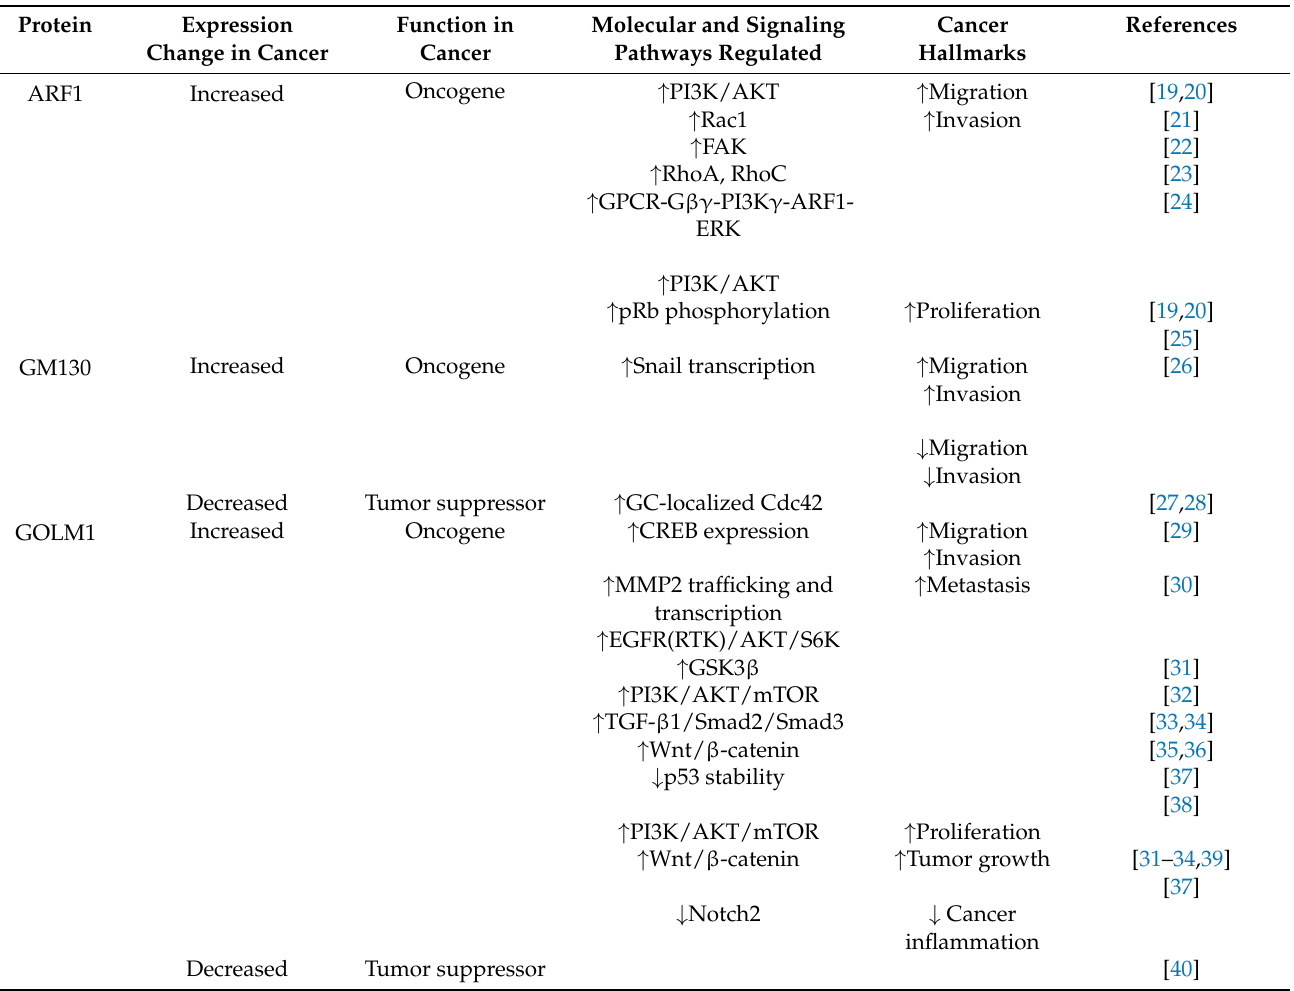
Table 1. GC protein-regulated pathways implicated in cancer